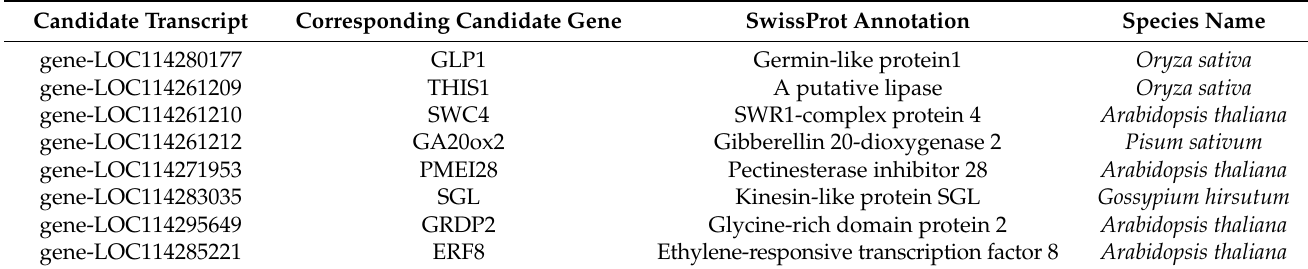
Table 5. Candidate genes related to the development of tree shape.